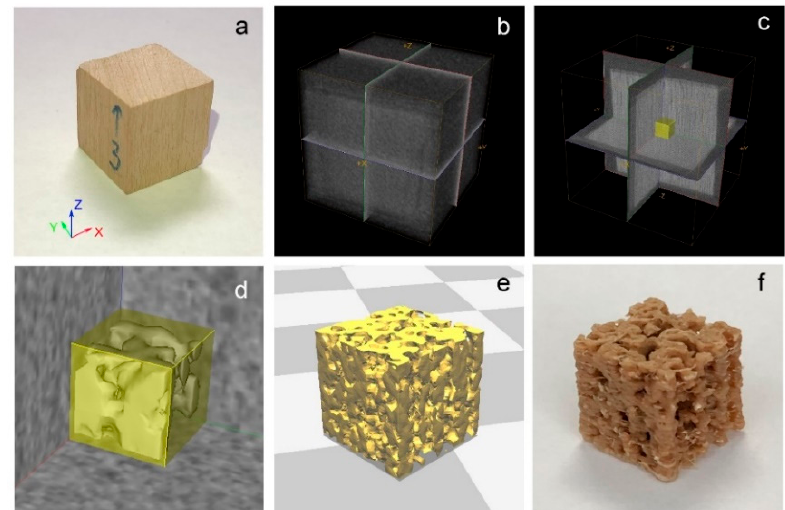
Figure 1. ( a ) wood sample; ( b ) 3D volume reconstruction; ( c ) region of interest (ROI) selection; ( d ) isosurface creation from the selected ROI; ( e ) printable elementary model in the CURA software; ( f ) printed scaled-up elementary model of composites on a scale of